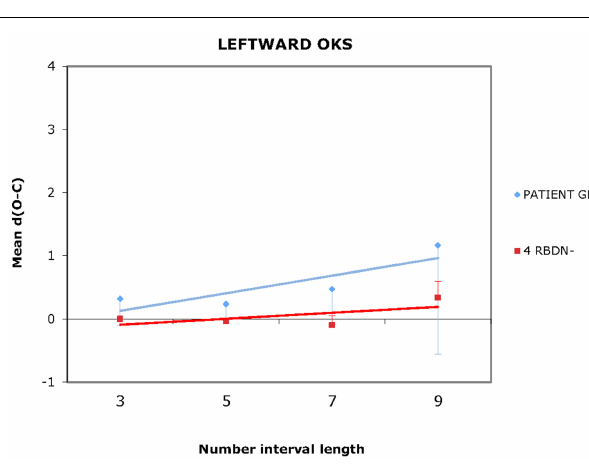
FIGURE 1 | In the static OKS condition, BG misbisected to the right of the true midpoint, as a function of number interval length.